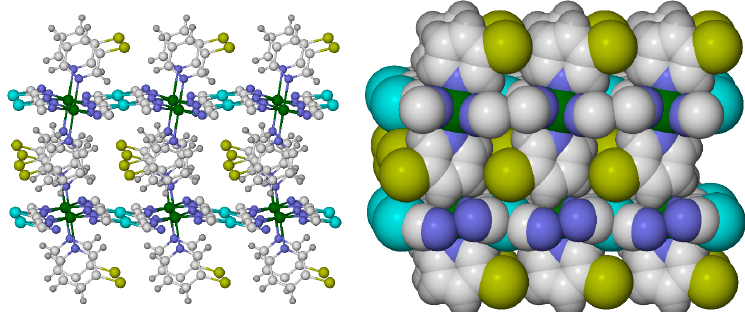
Figure 3. Two views of the 2D Hoffman network [Fe(3-Brpy) 2 {Pt(CN) 4 } 2 ], plotted from the same orientation [61]. The space-filling view shows the steric influence of the pyridyl bromo substituents in the interlayer space. Color code: C, white; H, pale gray; Br, yellow; Fe, green; N, blue; Pt, cyan.